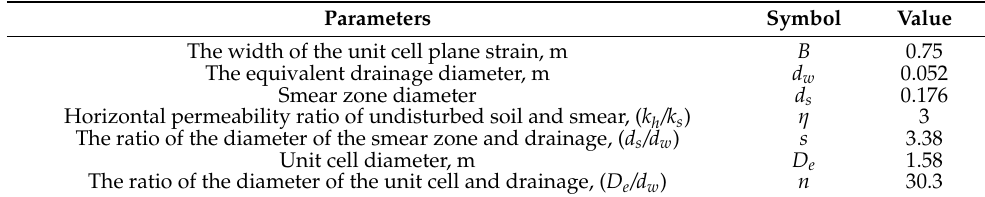
Table 2. Parameters of equivalent horizontal and vertical permeability.